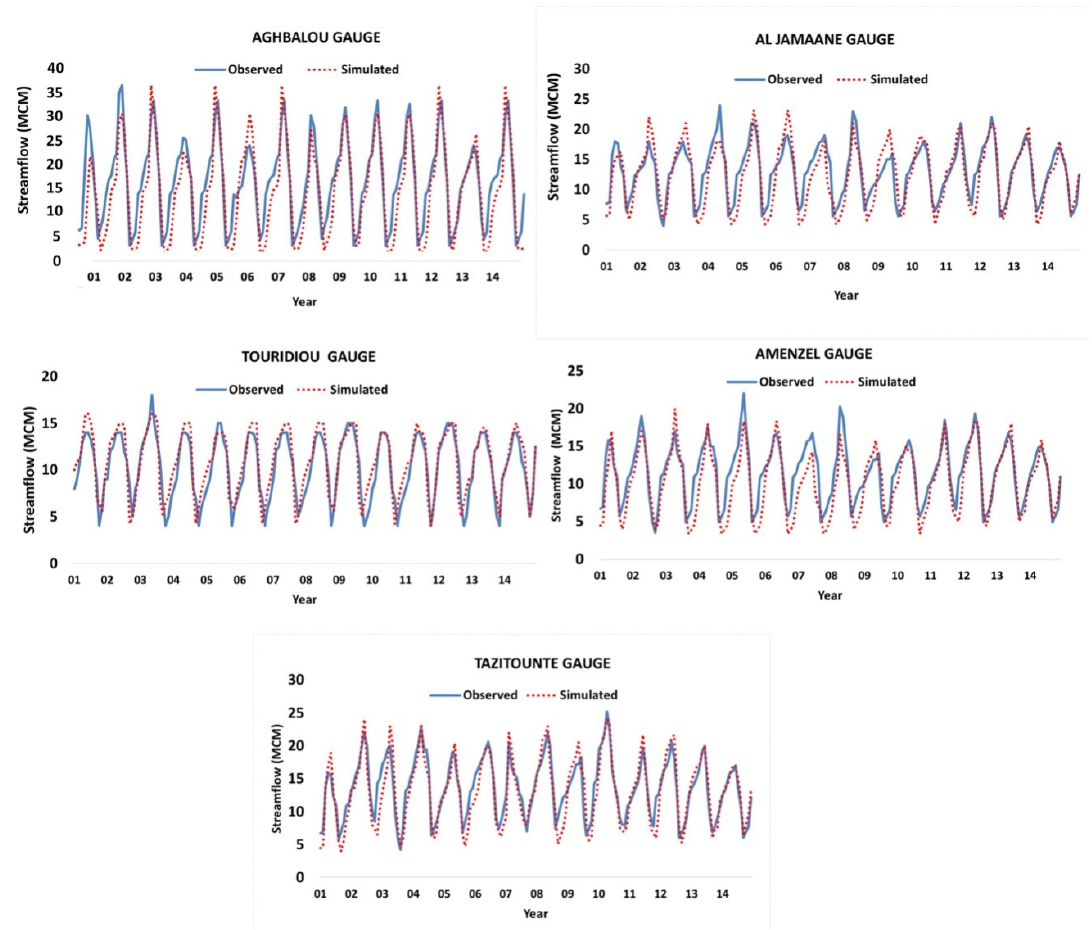
Figure 5. Projected Max and Min Temperatures for the future period until 2100.